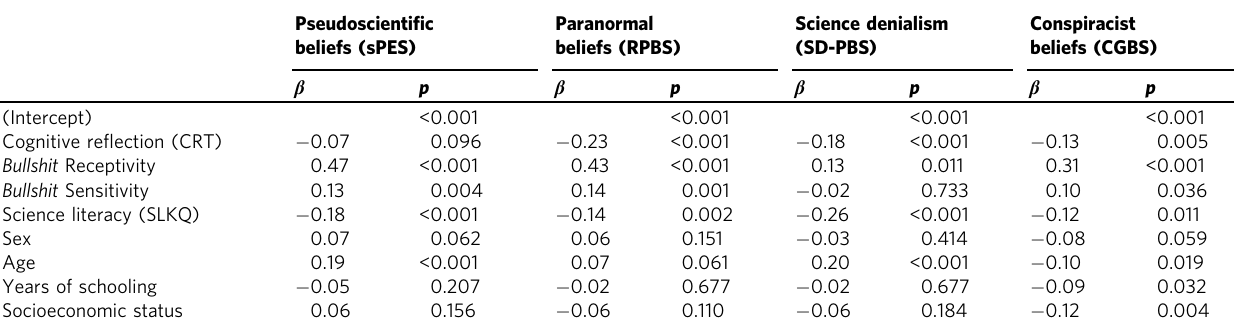
sPES stands for the short Pseudoscience Endorsement Scale. RPBS stands for Revised Paranormal Beliefs Scale. SD-PBS stands for the science denialism items of the Pseudoscienti fi c Beliefs Scale. GCBS stands for General Conspiracist Beliefs Scale. CRT stands for Cognitive Re fl ection Test. SLKQ stands for Science Literacy Knowledge